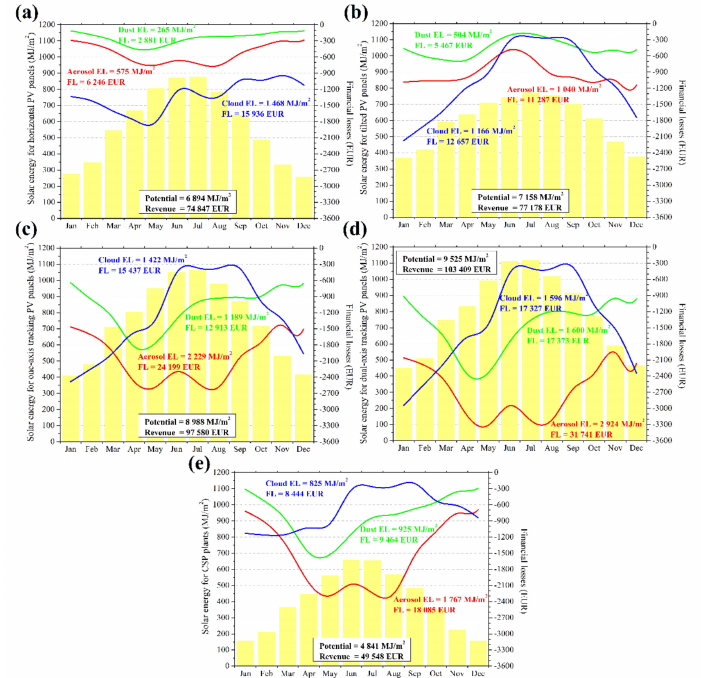
Figure 12. Financial analysis of the clouds, aerosol, and dust impacts on the produced solar energy from ( a ) a PV installation on a horizontal surface (zero tilt angle), ( b ) a PV installation where panels are tilted with a tilt angle equal to the latitude of the location, ( c ) a PV installation where panels are on a 1-axis solar tracking system (following the sun at the azimuthal direction), ( d ) a PV installation where panels are on a 2-axis solar tracking system (constantly perpendicular to the direct solar beam), and ( e ) a CSP installation,. In all cases the nominal power of the installations is 500 kW. The impact was quantified in terms of monthly mean and total financial losses and solar energy potential.